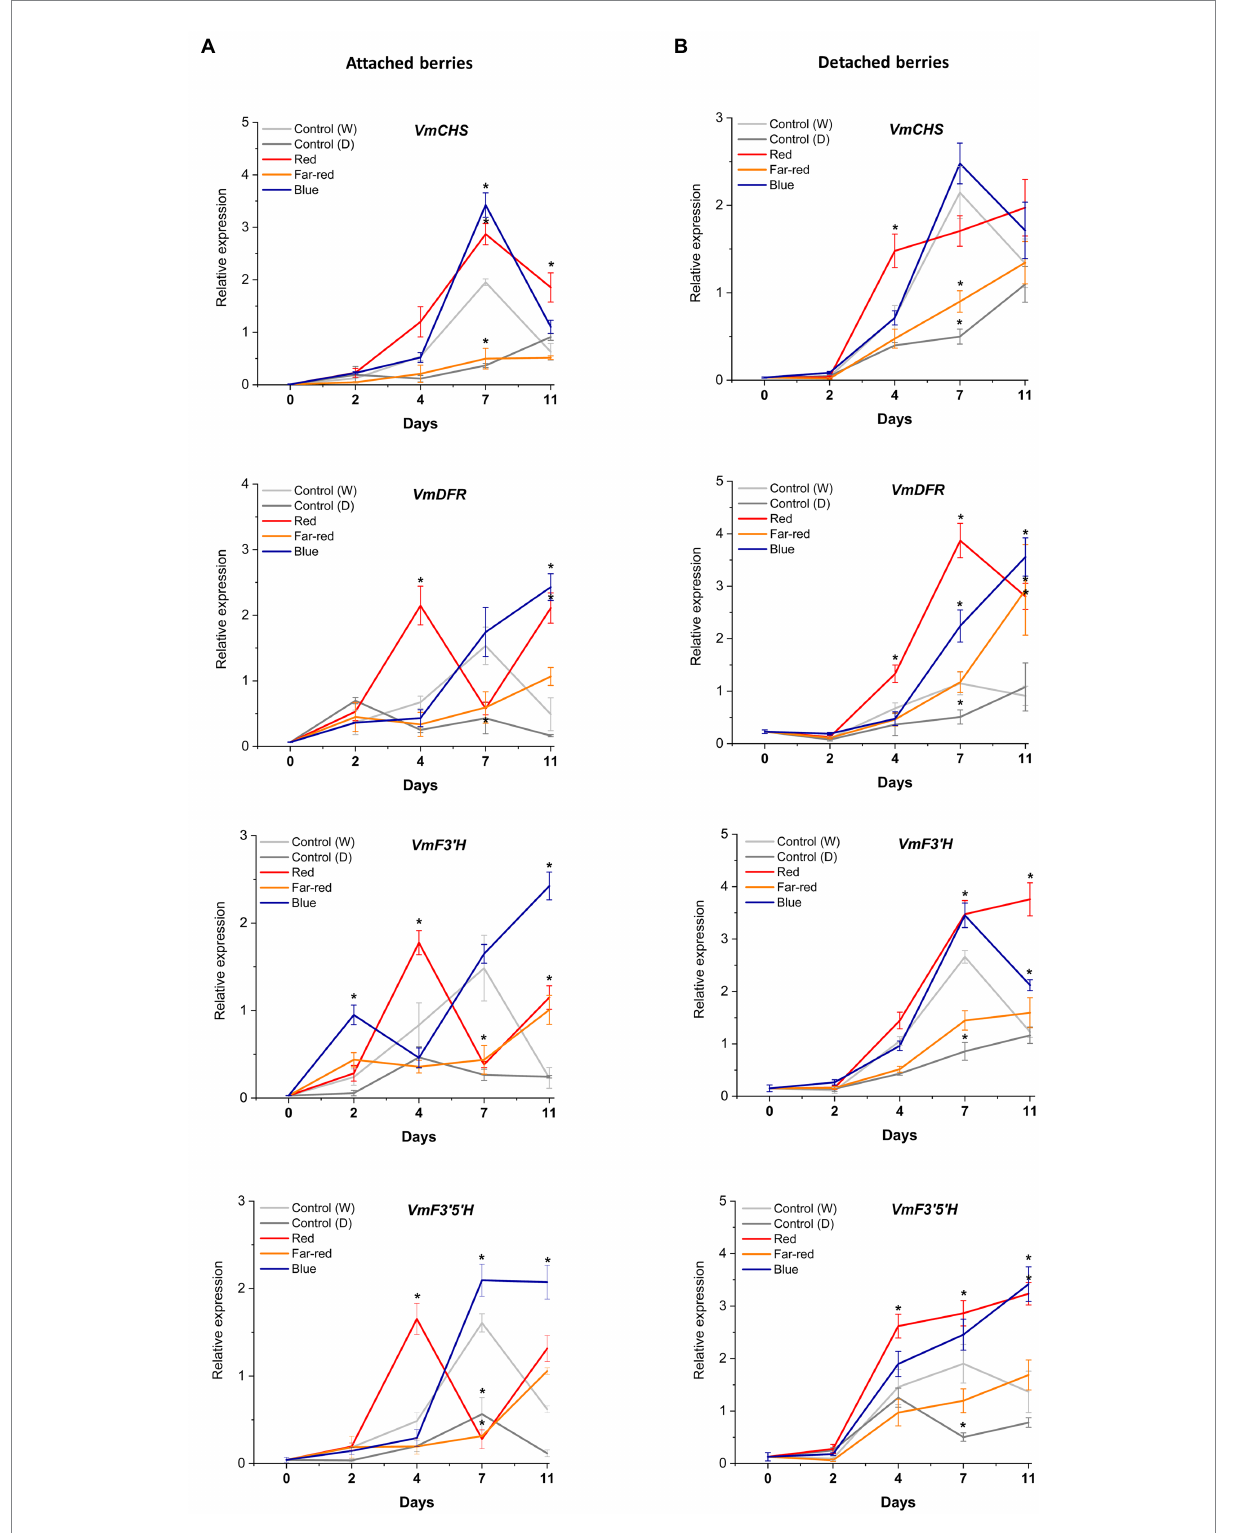
FIGURE 5 Effect of light spectral treatments on gene expression of early flavonoid biosynthetic genes chalcone synthase ( VmCHS ), dihydroflavonol 4-reductase ( VmDFR ), flavonoid 3 ′ hydroxylase ( VmF3’H ), flavonoid 3 ′ 5 ’ hydroxylase ( VmF3’5’H ) in attached berries (A) and in detached berries (B) . The expression levels were normalized to housekeeping gene glyceraldehyde 3-phosphate dehydrogenase ( VmGAPDH ) or actin . Expressed in average of three biological replicates ±SE and significant differences between control and light treatments were analyzed by comparison of means using Student’s t -test (in asterisks*) with value of p ≤